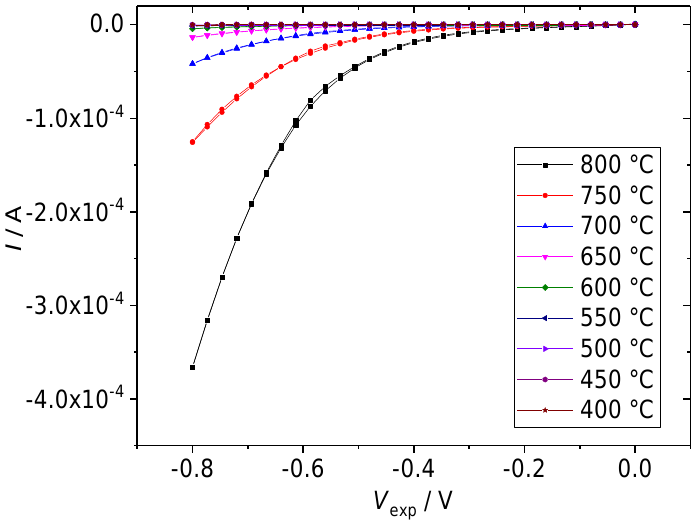
Figure 6. Experimental I-V curves for one Hebb-Wagner experiment for the sample with the composition Ce 0.9 Gd 0.1 Mn 0.01 O 2−δ .